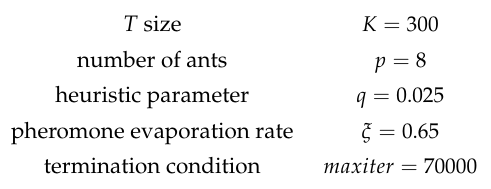
Table 2. ACO R initialization